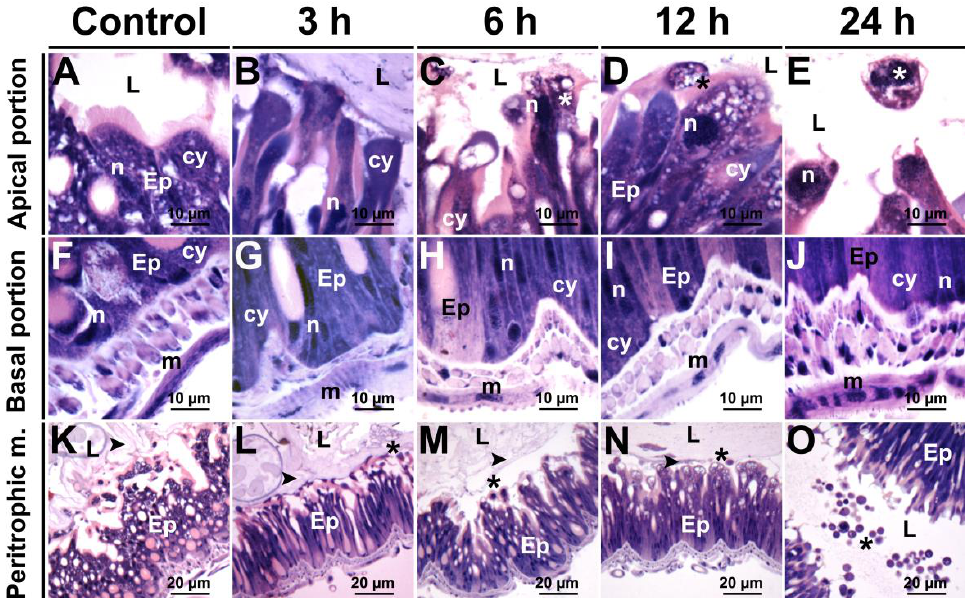
Figure 5. Light micrographs of the midgut of Spodoptera frugiperda caterpillars 3, 6, 12, and 24 h after exposure to deltamethrin. ( A – E ) Apical portion of digestive cells showing sequential effects with increase in vacuolization. ( F – J ) Basal portion of digestive cells showing sequential effects with increase in vacuolization. ( K – O ) Details showing sequential effects in the peritrophic matrix. Epithelium (Ep), lumen ( L ), peritrophic matrix ( ► ), cell protrusion (*). Control ( A , F , K ).